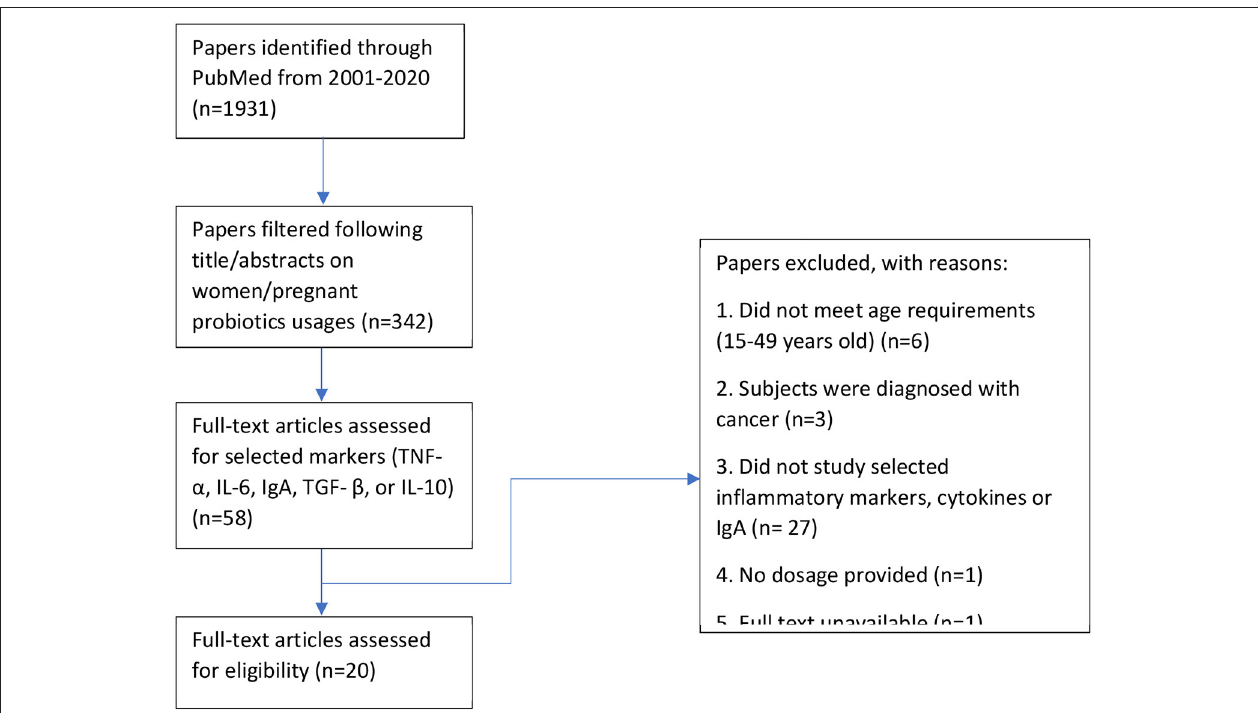
FIGURE 3 | Flow chart of the methodology used to search and select relevant literature results.